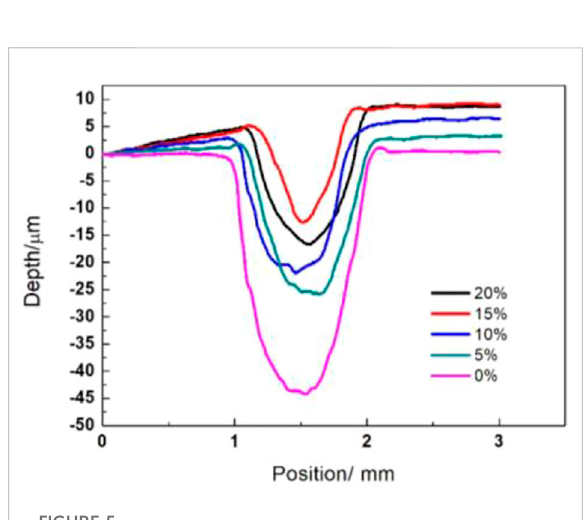
FIGURE 5 Measurement of wear pro fi le of AT13/Fe-based amorphous composite coatings (0 – 20 wt.%Al 2 O 3